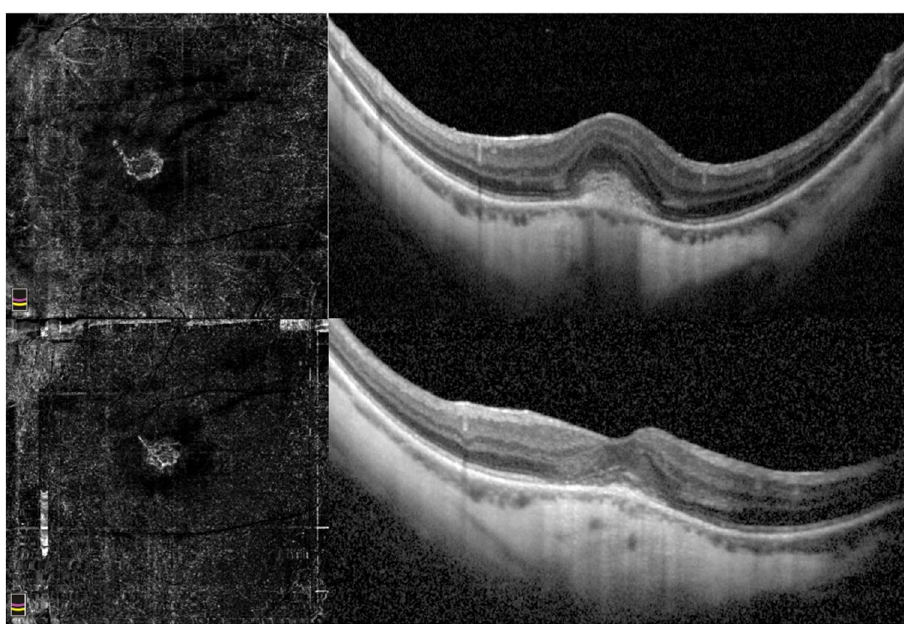
Figure 2. Mature myopic CNV. Baseline OCTA examination of a case of mature myopic CNV (top left) with wide subretinal hyperreflective exudation with fuzzy borders and absence of fluid accumulation signs assessed by SD-OCT (top right). The neovascular network at the final visit (12 months) after 5 intravitreal injections assessed by OCTA is still visible and shows a slight reduction of the size (bottom left). The SD-OCT exudation signs are regressed with absence of intraretinal cysts and subretinal fluid (bottom